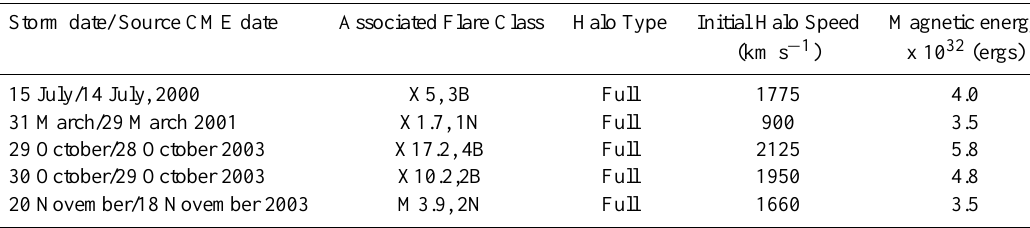
Table 1. The source CMEs of super-storms and associated flare characteristics